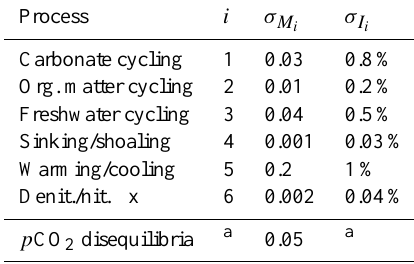
) and I i variability ( σ I ) for well-equilibrated surface i i